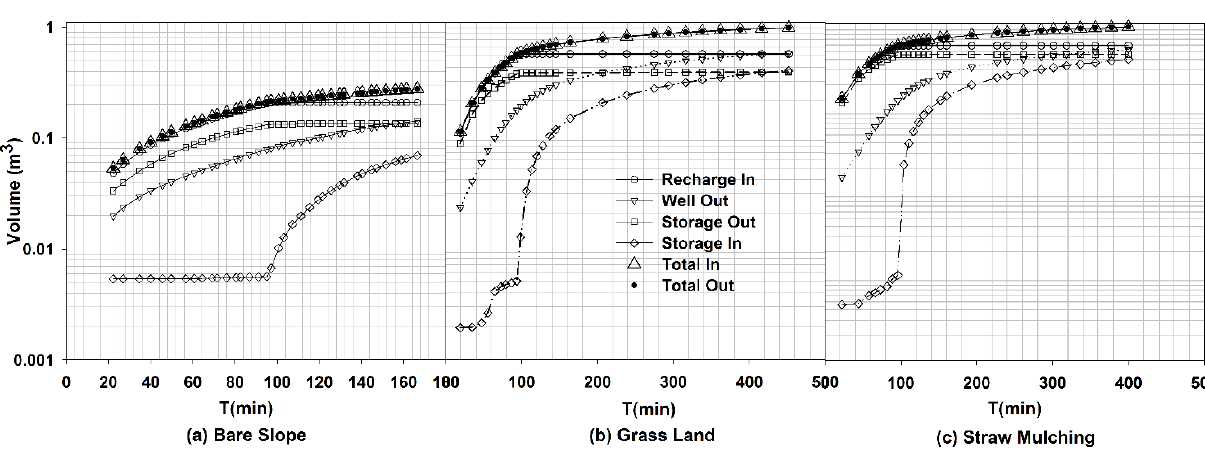
Figure 6. The flow mass balance graphs of the bare slope ( a ); grassland ( b ) and straw mulching scenarios ( c